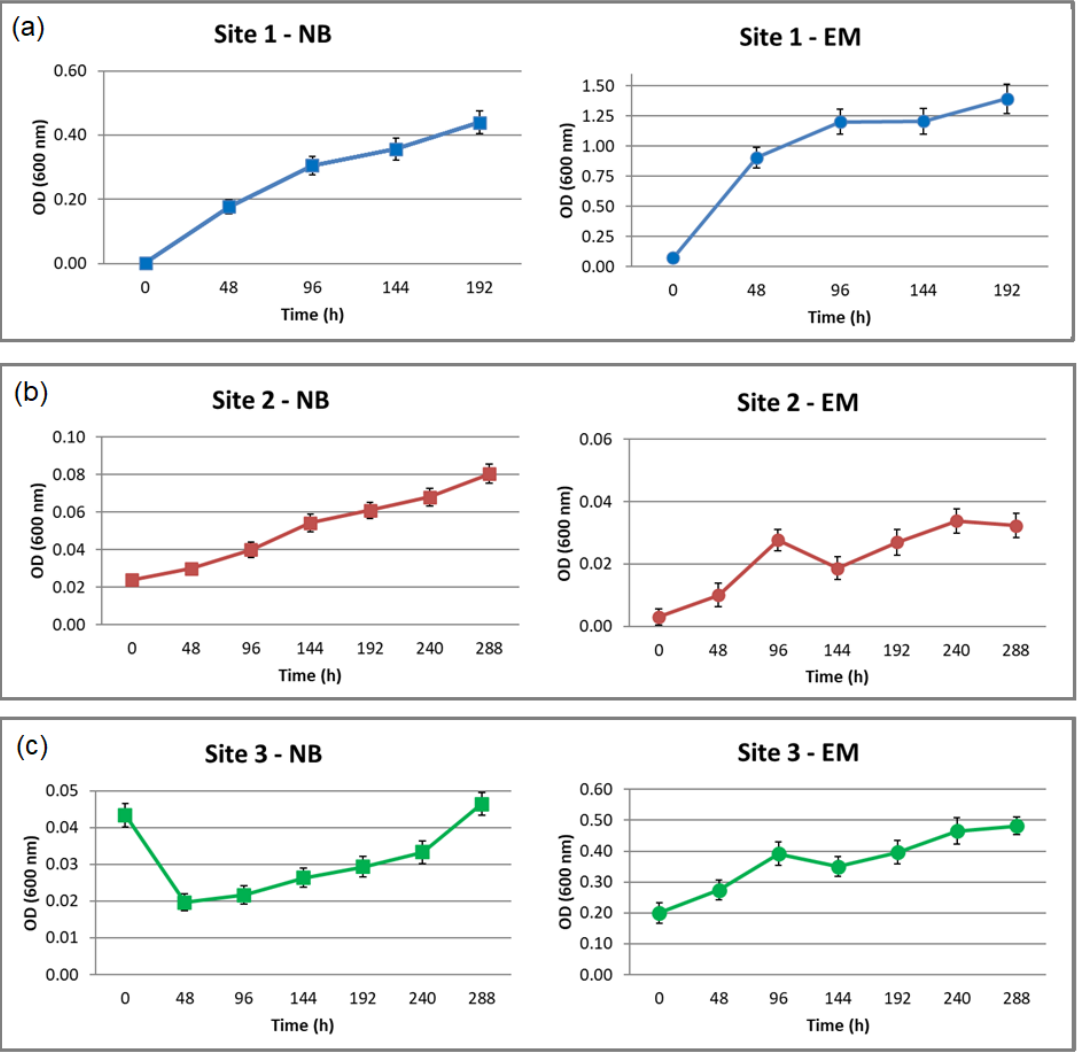
Figure 2. Growth of microorganisms isolated from El Chichón volcano crater lake in two culture media. ( a ) Microorganisms from Site 1, at pH 5.4 and 71.6 °C; ( b ) microorganisms from Site 2, at pH 4.2 and 80 °C and ( c ) microorganisms from Site 3, at pH 5.5 and 83 °C. Closed circles—enrichment medium (EM); closed squares—nutrient broth (NB).